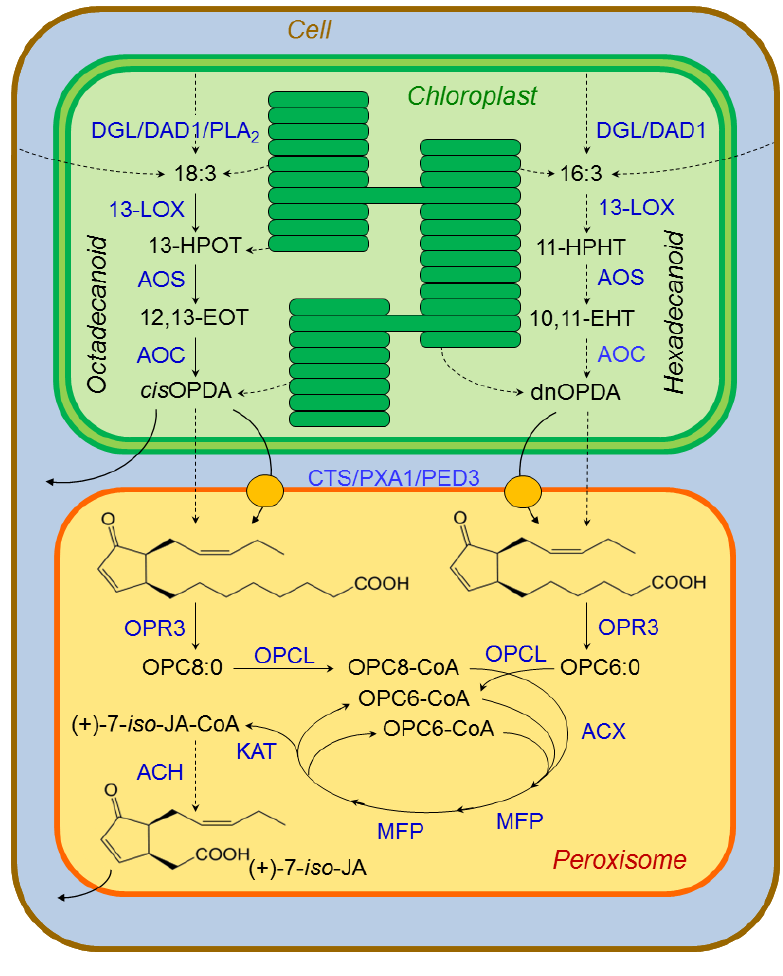
Figure 5. Biosynthesis of jasmonic acid in the chloroplast and peroxisome. Polyunsaturated fatty acids (18:3 and 16:3) released from the cell, chloroplast and/or thylakoid membrane are precursors for the biosynthesis of jasmonic acid (JA). Within the chloroplast, cis -(+)-12-oxo-phytodienoic acid ( cis OPDA) and dinor-OPDA (dnOPDA) are formed via the octa- and hexadecanoid pathways. After transport into the peroxisome, OPDA (dnOPDA) is reduced to OPC8:0 (OPC6:0) and undergoes three (two) cycles of β -oxidation that results in the production of (+)-7- epi -jasmonic acid. The reactions are catalyzed by lipoxygenases (LOX), allene oxide synthase (AOS), allene oxide cyclase (AOC), ATP-binding cassette (ABC) transporter COMATOSE (CTS/PXA1/PED3), 12-oxophyto-dienoate reductase (OPR3), OPC CoA ligase1 (OPCL), acyl-thioesterase (ACH), 3-ketoacyl-CoA thiolase [132], acyl-CoA oxidase (ACX) and a multifunctional protein (MFP). Enzymes are shown in blue. Arrows show the well characterized reactions, whereas dashed arrows show steps that are still hypothetical, and for which the corresponding enzymes remain to be identified. (Adapted from